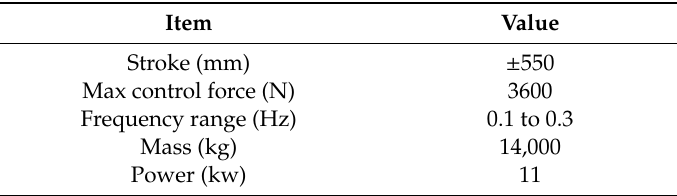
Figure 3. ( a ) Finite element model and ( b ) target mode shape (first vertical mode). Table 1. Specifications of actuator.